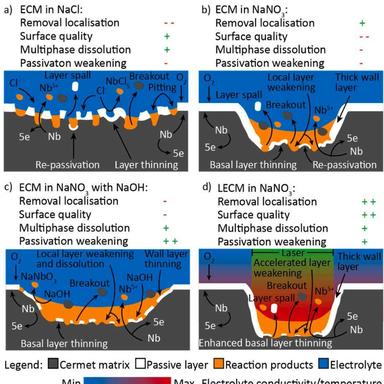
Proposed NbC–Ni cermet material removal mechanisms and machining performance with ECM in different electrolytes and LECM in NaNO3.